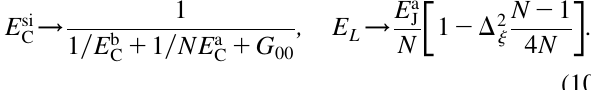
FIG. 3. Physical interpretation of Young diagrams. (a) Each subspace labeled by a Young diagram of shape ð N (cid:3) 1 ; 1 Þ is spanned by N states in which one array junction is excited relative to the other N (cid:3) 1 array junctions. These states are linearly dependent and can be decomposed into difference- mode excitations. For example, the irreducible ð N (cid:3) 1 ; 1 Þ sub- has a basis that is comprised of the N (cid:3) 1 difference- space V 1 ~ 0 i that are collective excitations distrib- mode excitations a y (cid:6) j d uted across multiple junctions (see Fig. 2). (b) Subspaces with higher junction excitations are associated with Young diagrams with additional